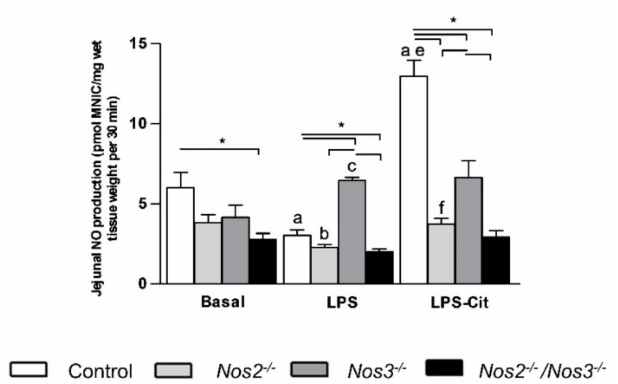
Figure 3. NO production in jejunal tissue of control and Nos -deficient mice during basal and endotoxemic conditions, and after L-citrulline supplementation during endotoxemia. Basal jejunal NO production (in pmol MNIC/mg wet jejunal tissue) in control and Nos -deficient mice under basal and endotoxemic conditions with or without L-citrulline supplementation. * p -value < 0.05; a p -value < 0.05 vs. control mice under basal conditions; b p -value < 0.05 vs. Nos2 − / − mice under basal conditions; c p -value < 0.05 vs. Nos3 − / − mice under basal conditions; e p -value < 0.05 vs. control + LPS; f p -value < 0.05 vs. Nos2 − / − mice + LPS. Data are shown as mean ± SEM. Statistical